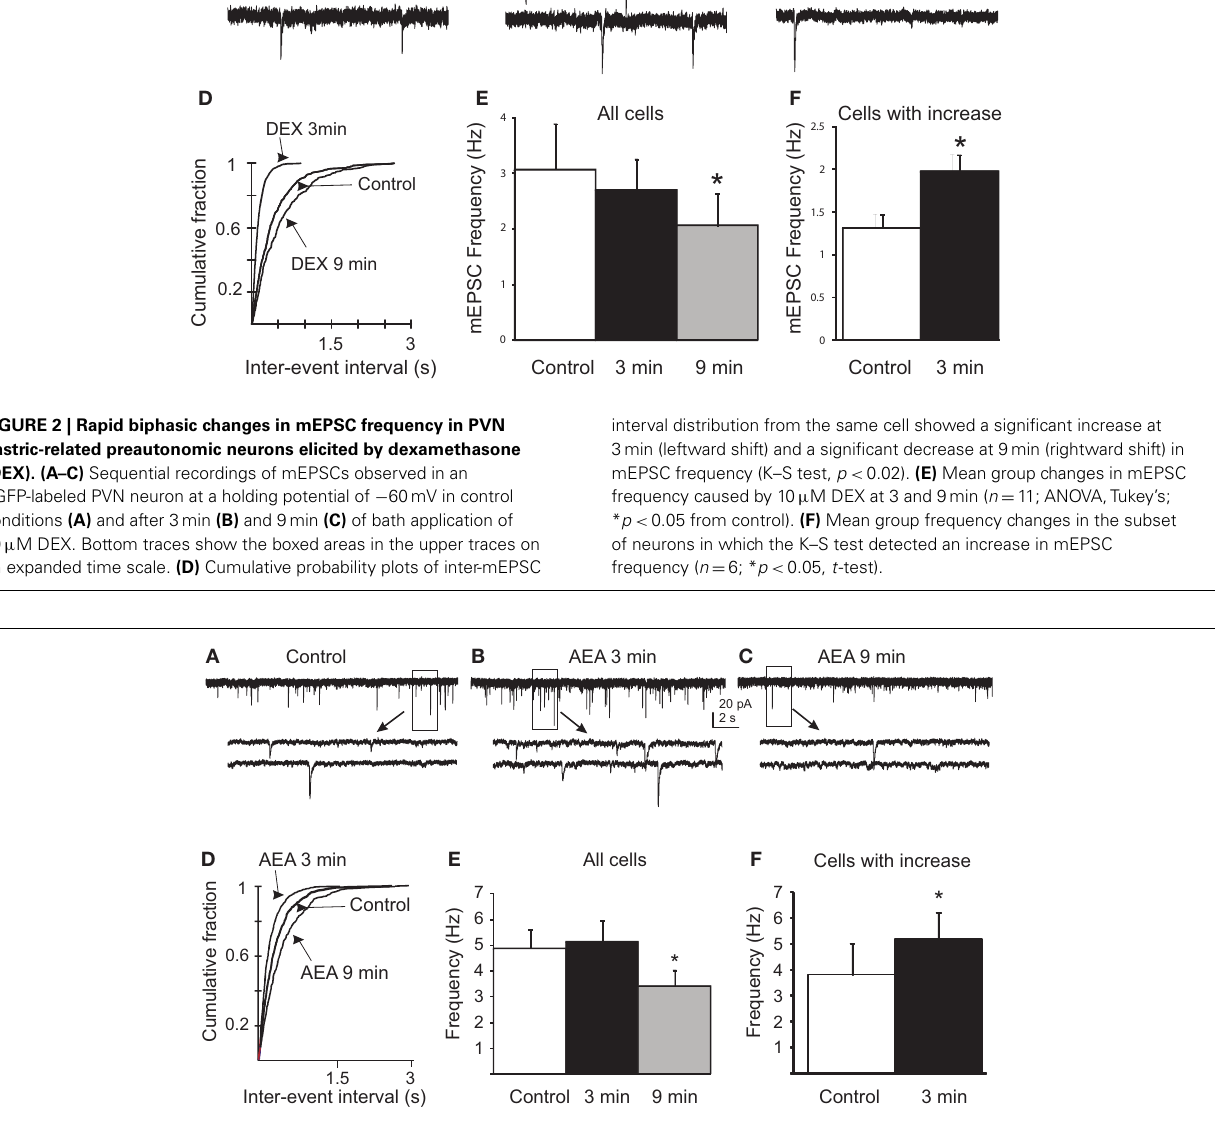
FIGURE 3 |Anandamide biphasically altered mEPSC frequency in gastric-related preautonomic neurons. (A–C) Sequential recordings of mEPSCs observed in EGFP-labeled PVN neurons at a holding potential of − 60mV in control conditions (A) and after 3min (B) and 9min (C) of bath application of 10 µ M AEA. Bottom traces show the boxed areas in the upper traces on an expanded time scale. (D) Cumulative probability plots of inter-mEPSC interval distribution from the same cell showed a significant